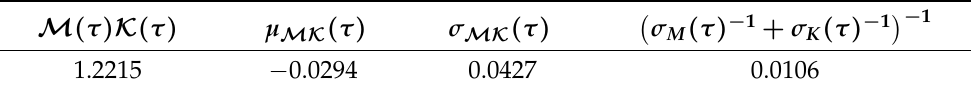
Table 6. Mean and Standard Deviation for the Discounted Expected and Unexpected Gross Growth Rate of Trading Desk Manager’s